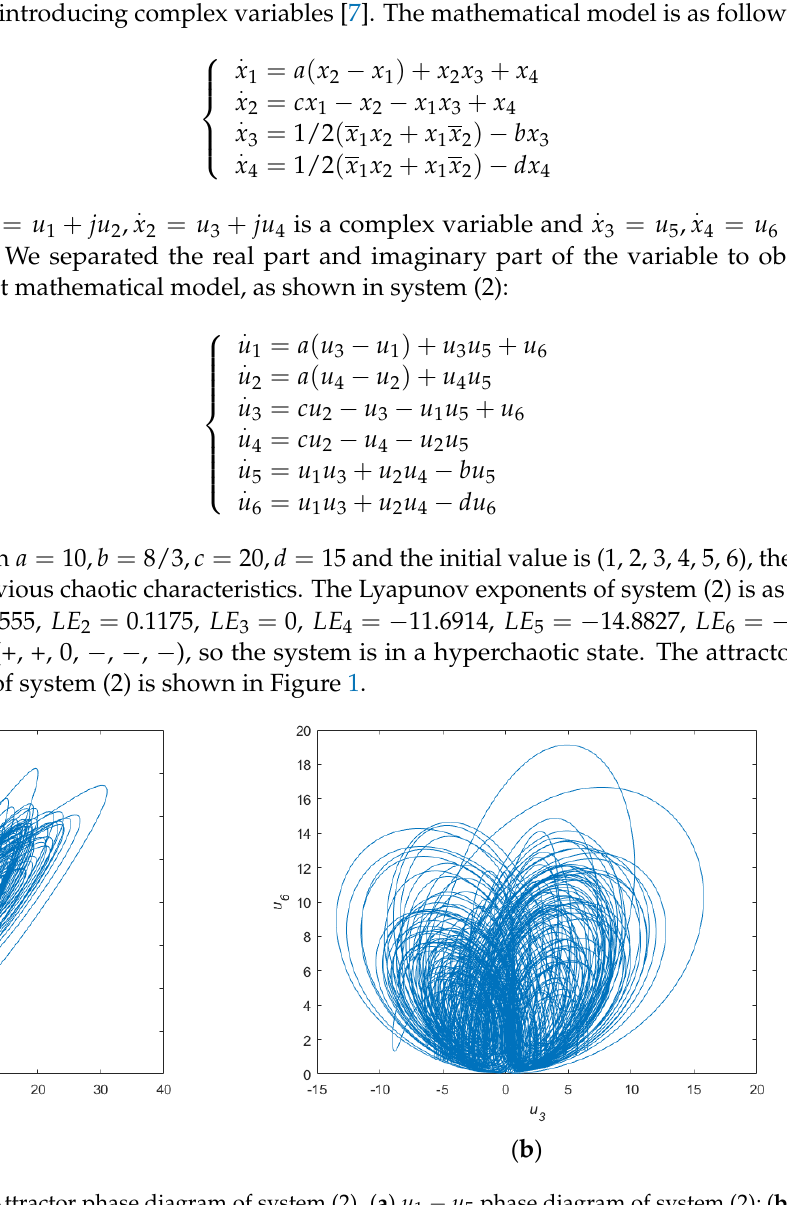
Figure 1. Attractor phase diagram of system (2). ( a ) 𝑢 1 − 𝑢 5 phase diagram of system (2); ( b ) 𝑢 3 − 𝑢 6 phase diagram of system